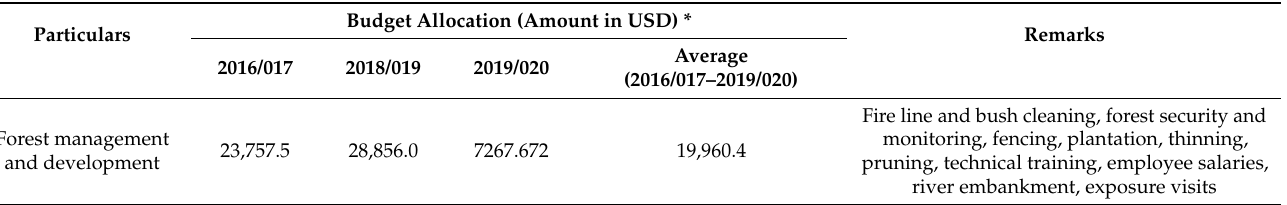
Table 2. Budget allocation in different livelihood assets during some recent fiscal years (amounts are in USD)